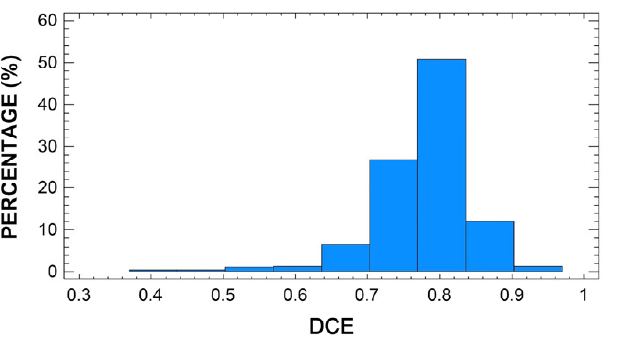
Figure 2. Frequency distribution (histogram) of dry curd efficiency (DCE) in Manchega sheep milk ( n = 967).